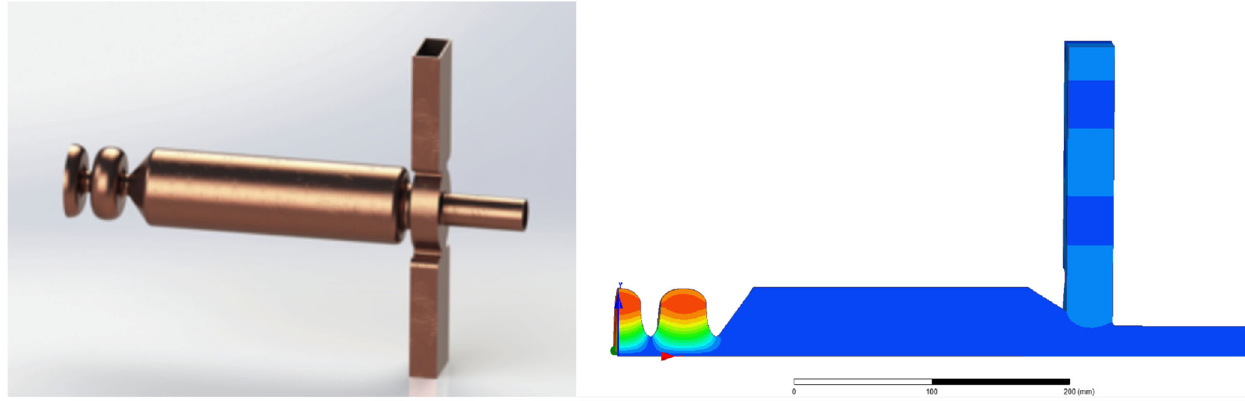
FIG. 16. (left) Three-dimensional outside view rendering of rf photoinjector and external power coupling, showing on right symmetrized waveguide feeding a mode-launcher style coupler. Cylindrical waveguide then axially couples power into 1.45 cell gun structure. (right) Surface magnetic fields in coupler and gun, as simulated in HFSS, with color map extending from 0 (blue) to 5 × 10 5 A = m